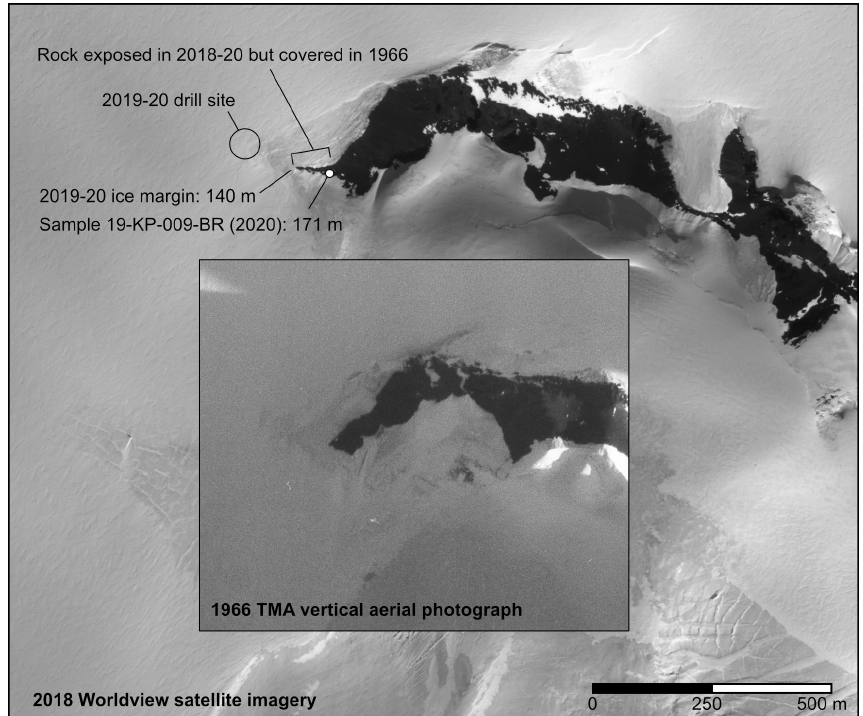
Figure 3. WorldView satellite imagery (© 2018, Maxar) collected on 8 December 2018 (main image) showing the north end of Kay Peak Ridge, compared with a US Navy vertical trimetrogon aerial (TMA) photograph (inset image) taken on 5 January 1966 (TMA1720, frame 231V). The 1966 photograph is not geolocated, so the images were adjusted to a common scale by matching bedrock features on the lower ridge. This comparison does not attempt to correct for look angle, so comparison of the extent of exposed rock is not quantitative. However, the shape of the ice margin clearly indicates that a portion of the lower ridge exposed in 2018 was not exposed in 1966. In fieldwork in 2019–2020, we collected samples from the portion of the ridge that was ice covered in 1966 and surveyed sample locations and the lowest exposed rock on the ridge using a combination of handheld GPS, differential GPS, and barometric elevation measurements. Based on the image comparison, the highest sample that was clearly ice covered in 1966 has a present elevation of 171m. As the present ice margin is at 140m elevation, the elevation of the ice margin decreased at least 31m between 1966 and